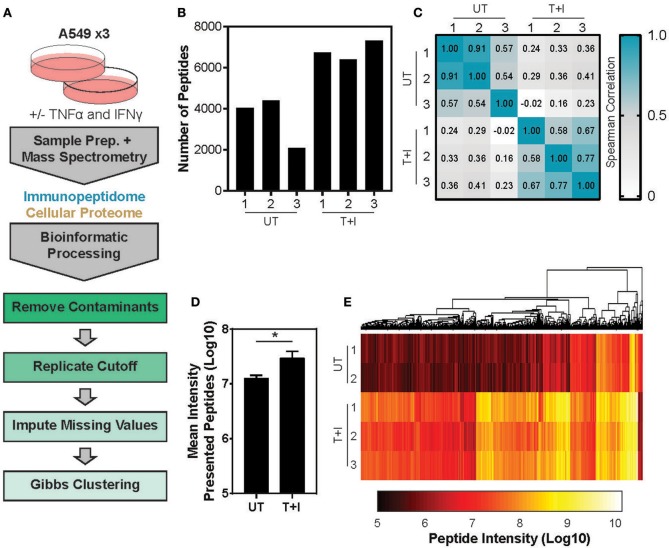
Analyzing the TNFα and IFNγ stimulated presented peptidome. (A) Experimental and informatics workflow includes stimulation of A549 cells with TNFα and IFNγ for 24 h, harvesting samples which were subject to MS-analysis of both the peptides presented on MHC I (immunopeptidome) and total cellular lysates (Cellular Proteome). Thousands of peptides were identified, common contaminates were removed as well as peptides which were not identified in at least 2 of 3 replicates (replicates). Missing values were imputed to randomly chosen values from a normal distribution and the resulting peptides were subject to Gibbs Clustering. (B) The number of unique peptides identified in the presented peptidome of each of the 3 triplicates stimulated with TNFα and IFNγ (T+I) or left untreated (UT). (C) Spearman Rho of the peptide intensities from each pairwise combination of samples. (D) The mean presented peptide intensity (Log10) in the unstimulated (UT) and stimulated (T+I) samples (*p = 0.0215; error bars indicate SD). (E) Supervised clustering of peptide intensities with and without stimulation of cells with TNFα + IFNγ (T+I). Only peptides which significantly differed in abundance between the two conditions are displayed (city-block distance function on Log10 transformed intensity). Significance is determined as p ≤ 0.05 (Benjamini-Hochberg FDR corrected P-values, student's t-test).